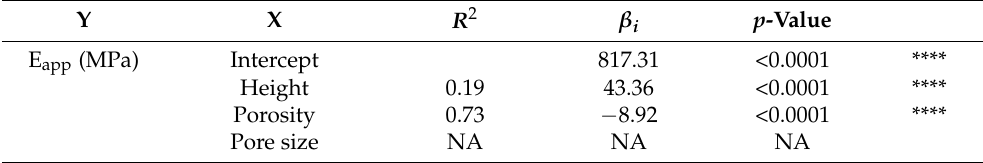
Table 5. Step-wise statistical analysis with models for the three response variables.